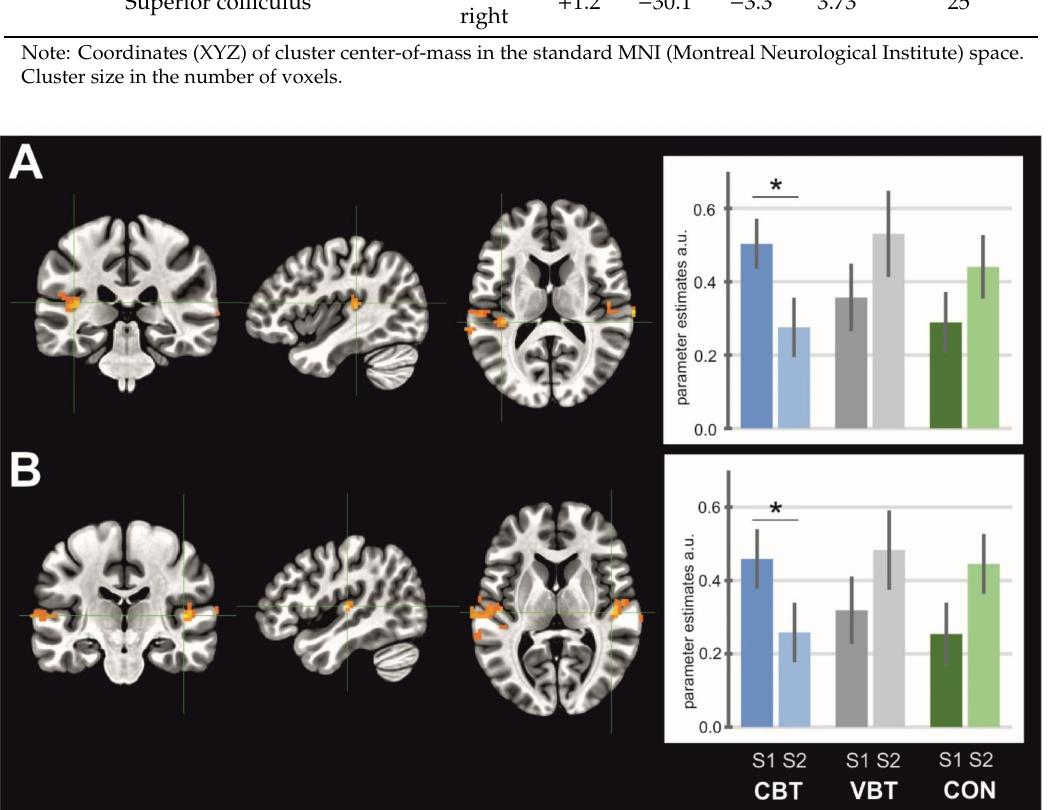
Figure 4. Brain structures showing interaction between groups and sessions for AO task; ( A ) left supramarginal gyrus / posterior insula, ( B ) right supramarginal gyrus / posterior insula. Note: CBT— classical balance training, VBT—virtual reality balance training, CON—control group; asterisk indicates significant di ff erences between